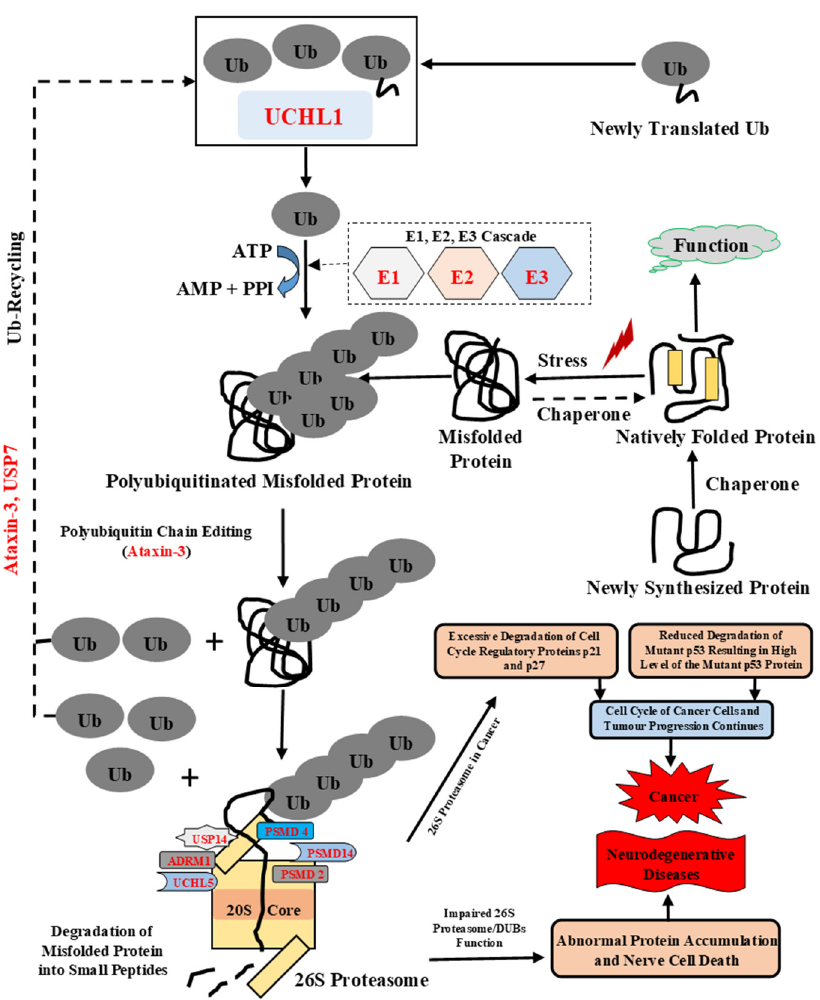
Figure 1. Schematic representation of the ubiquitin proteasomal system. Ubiquitination is an ATP- dependent process performed by three enzymes: E1 (Ub-activating) enzyme, E2 (Ub-conjugating) enzyme, and E3 (Ub-ligase) enzyme. The DUBs, such as ataxin-3, modify the polyubiquitinated chain, to confirm accurate recognition of the misfolded proteins by the 26S proteasome. This covalent modification of misfolded protein targets them to multicatalytic protease complex, the 26S proteasome. Ubiquitination is reversed by DUBs and disassembles polyubiquitin chains. DUBs such as USP7, UCHL1, and ataxin-3 also control and maintain free Ub molecules in the cell. UCHL1 modifies newly translated protein and maintains a pool of mono-Ub. The polyubiquitinated misfolded protein can bind either to the Ub receptor of the 19S regulatory complex or to an adaptor protein that consists of both poly-Ub binding and proteasome binding domain [27]. Once misfolded protein binds to proteasome, the unfolding of the misfolded protein occurs by ATPases followed by removal of the poly-Ub chain by proteasome-associated DUBs and further translocation and degradation of unfolded protein in central proteolytic chamber occurs. Excessive degradation of cell-cycle-regulatory proteins such as p21 and p27 and reduced degradation of mutant p53 leads to a continuous cell cycle of cancer cells and tumor progression leads to the development of cancer [28]. Additionally, impairment in function of 26S proteasome, ubiquitinating enzymes, and DUBs can lead to nerve cell death and the progression of neurodegenerative diseases. Ub: Ubiquitin, E1: Ub-activating enzyme, E2: Ub-conjugating enzyme, E3: Ub-ligase